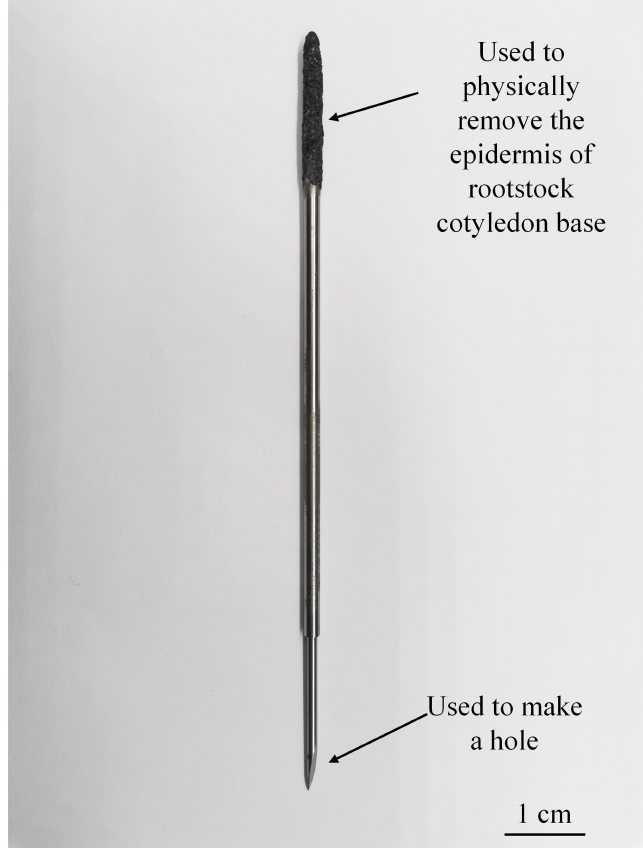
Figure 1. New grafting tool used in this study.